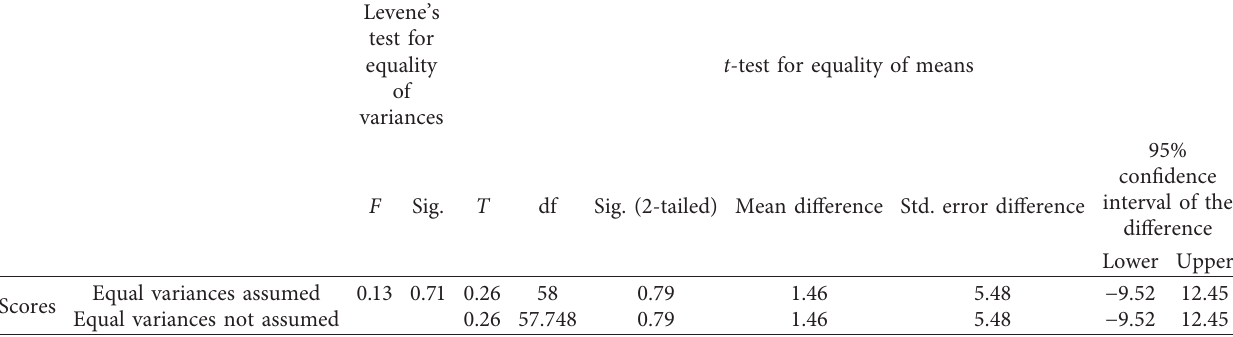
Table 6: Independent-samples t -test (reading motivation pretest).